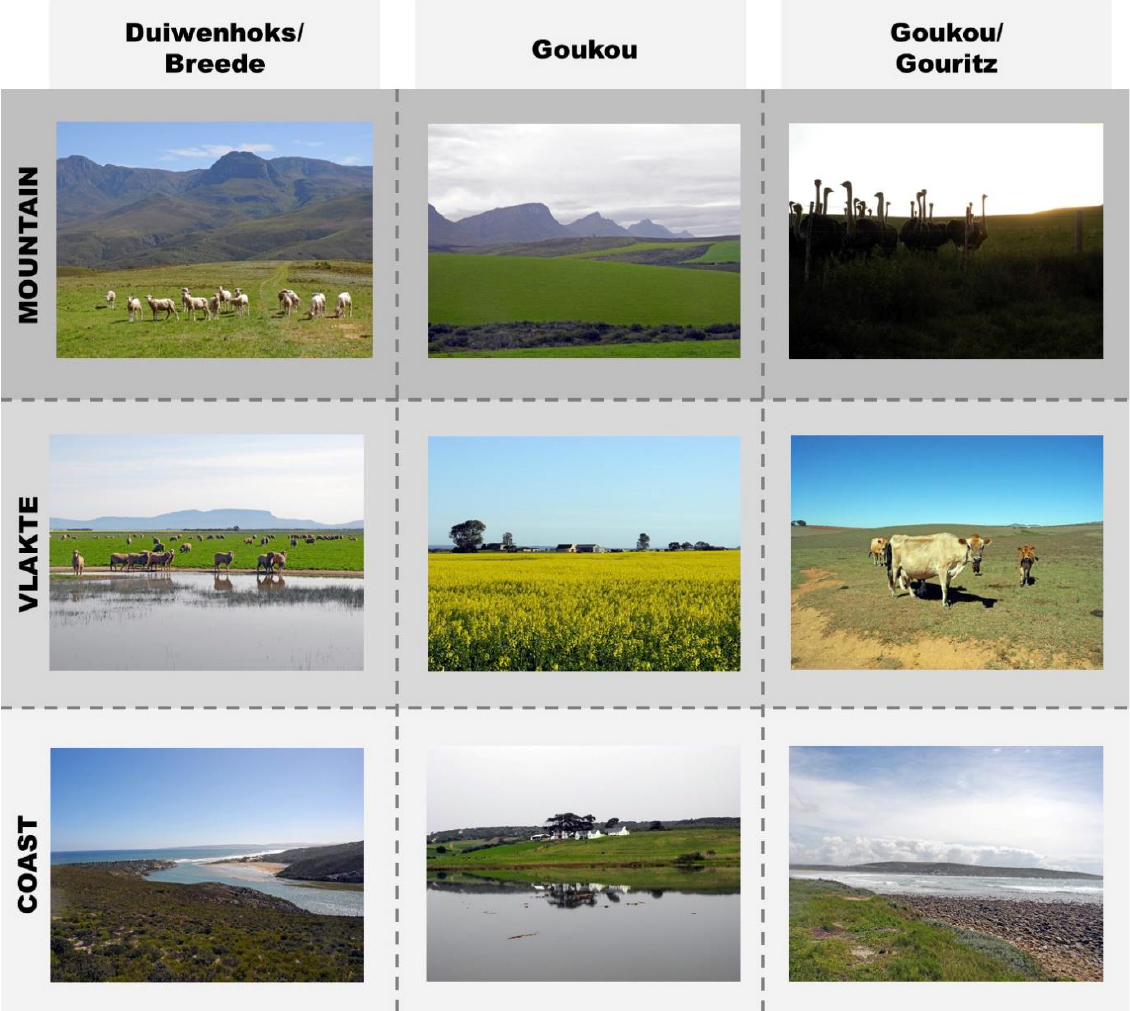
Figure A1.2: The six grouping describing location characteristics throughout the research area according to catchment (Duiwenhoks/Breede, Goukou and Goukou/Gouritz) and area (mountain, vlakte and